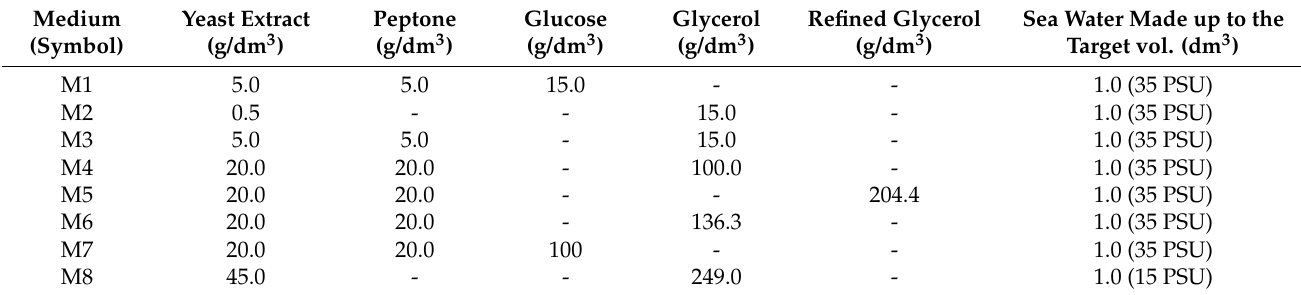
Table 1. Composition of the growth media used in the